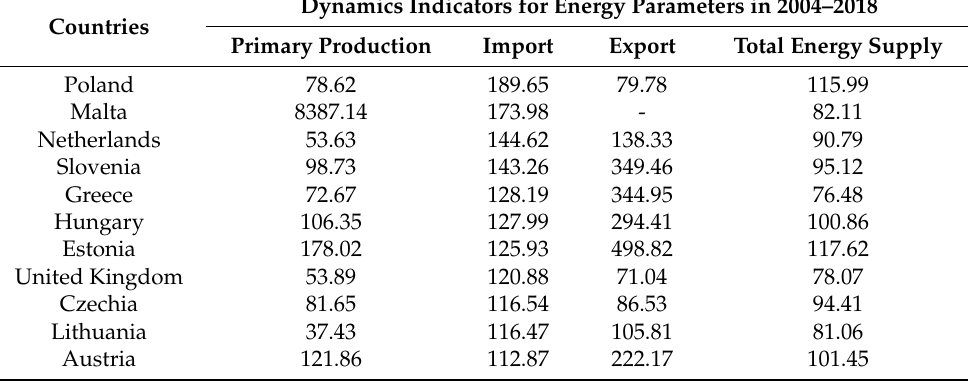
Table 1. Dynamics indicators for energy parameters in EU countries in 2004–2018 (year 2004 =